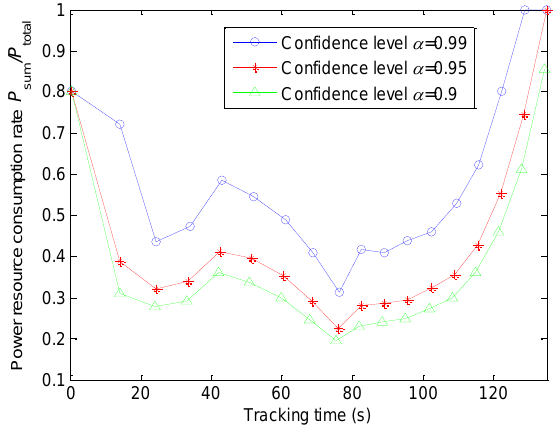
Figure 9. Power consumption of different confidence levels.